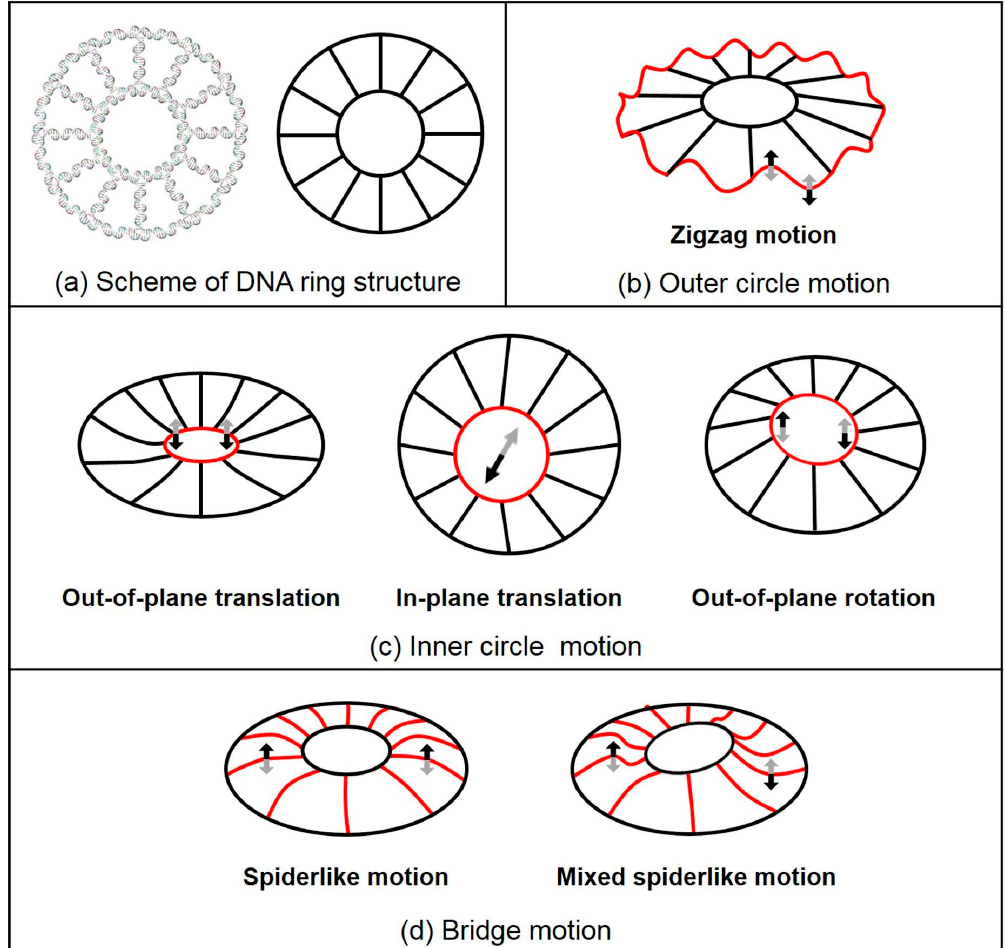
Figure 3. Schematics of the DNA 2D ring structure and its major vibration modes. These modes are classified into three different motions, including outer circle motion, inner circle motion, and bridge motion. ( a ) Scheme of the DNA ring structure. ( b ) Zigzag motion, outer circle motion, is sinusoidal and the shape of outer circle is red. The 8th–10th mode at R1 rings and the 4th–10th mode at R2 rings are shown. ( c ) Inner circle motions consist of out-of-plane translation, in-plane translation, and out-of-plane rotation of inner circle (indicated in red). Out-of-plane and in-plane translations are the inner circle of the DNA ring structure moving in vertical and lateral directions, respectively. Out-of-plane rotation is the seesaw motion of the inner circle. For all ring structures, out-of-plane translation and out-of-plane rotation are dominant motions, as shown in the 1st mode and both the 2nd and 3rd modes, respectively. In-plane translation can be observed only at R1 rings over the 7th mode. ( d ) Bridge motion is composed of spiderlike and mixed spiderlike motions. Spiderlike motion is the bridge bending motion in the upper direction and is observed in all ring structures. It is present in the 4th mode of R1 rings. Mixed spiderlike motion is also shown in both the 5th and the 6th modes of the R1 rings.